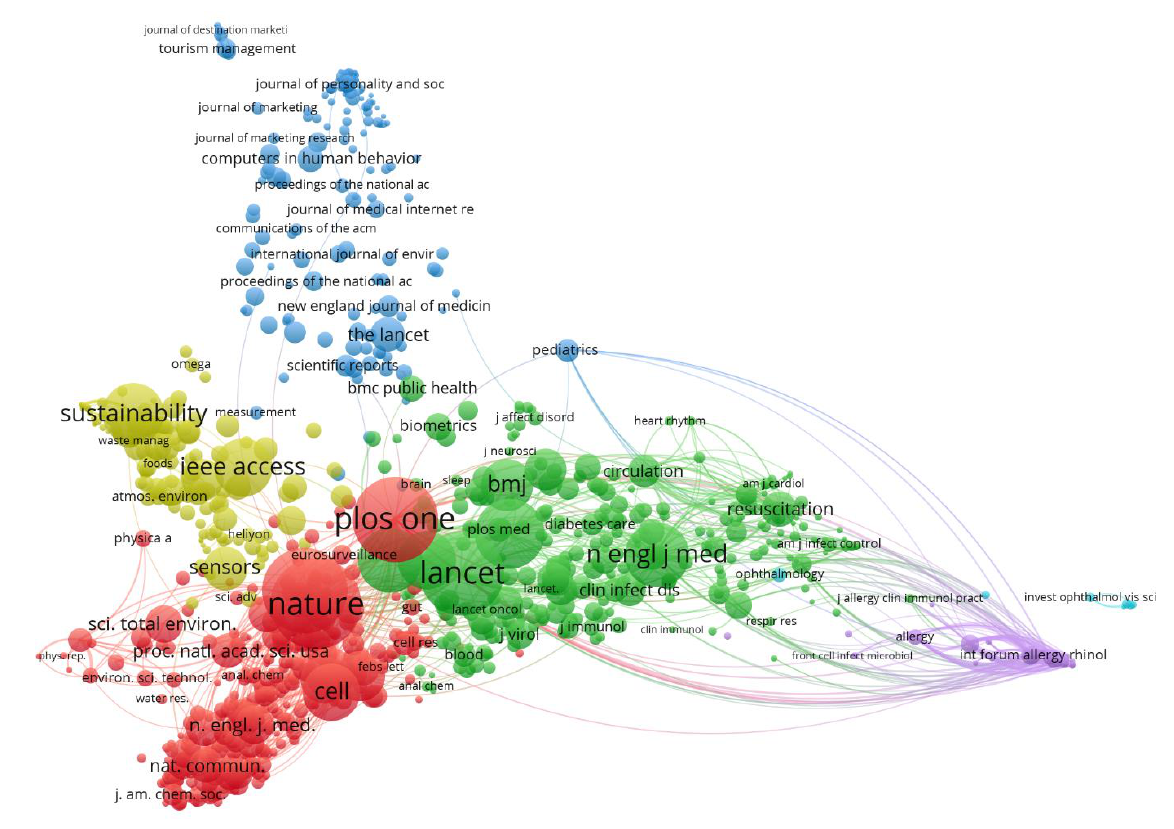
Figure 10. Co-citation mapping by sources (source Scopus).